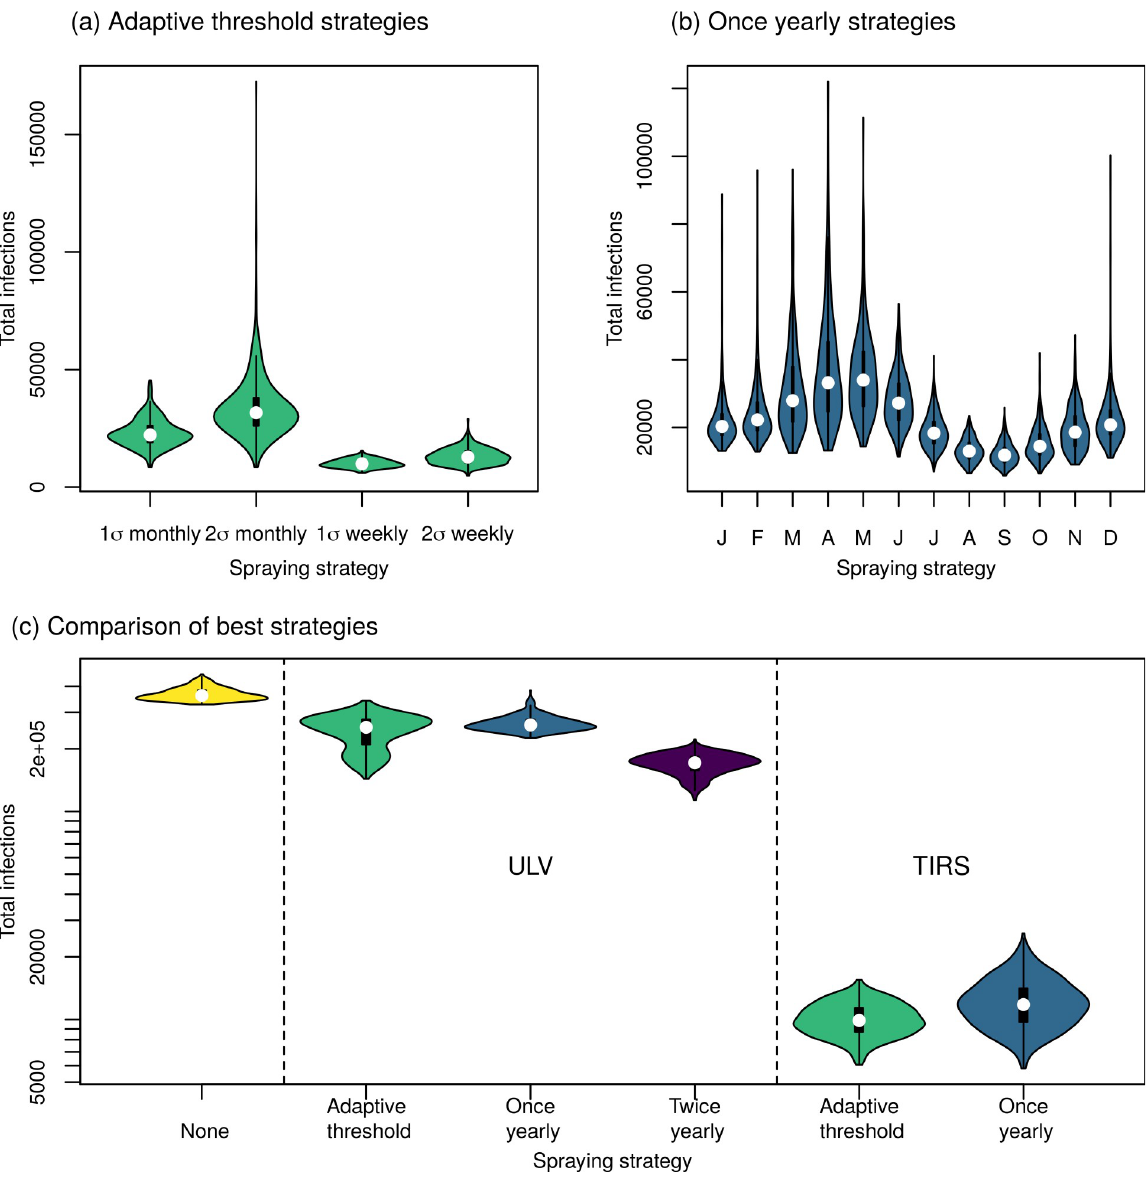
Fig 8. Predicted human infections following city-wide TIRS spraying. (a) Comparison of adaptive threshold strategies for initiating spraying– spraying began when the monthly or weekly incidence was one or two standard deviations above the mean for that period from the last five years, as shown on the x-axis. (b) Comparison of yearly city-wide spraying strategies, began on the first day of the indicated month. (c) Comparison of the best strategies in each category of both ULV and TIRS: for ULV, adaptive threshold corresponds to starting when monthly incidence was more than one standard deviation above the mean, once yearly corresponds to spraying in September, and twice yearly corresponds to spraying in September and November; for TIRS, adaptive threshold corresponds to starting when weekly incidence is more than one standard deviation above the mean, and once yearly corresponds to spraying in